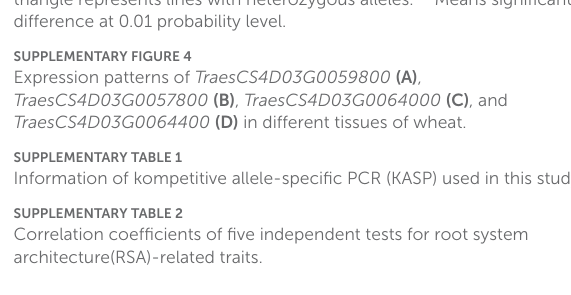
SUPPLEMENTARYTABLE3 Genotypes of Chinese wheat landraces